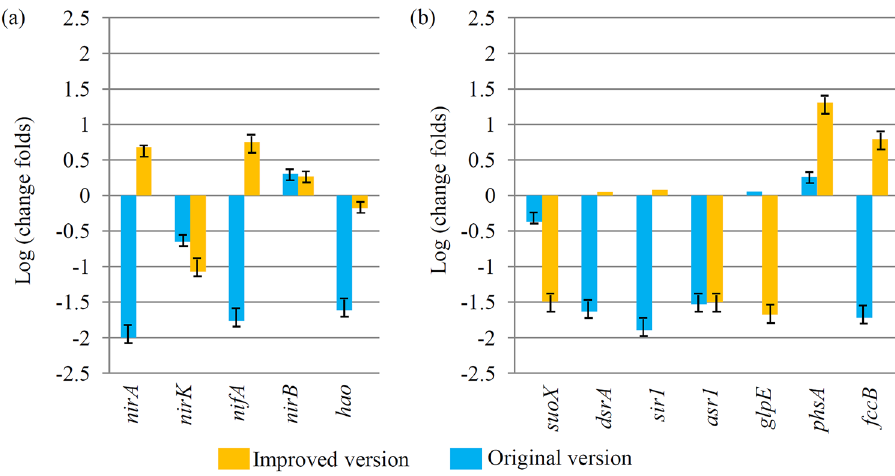
Figure 6. Comparison of the functional genes between original and improved biofilters. ( a ) The average expression levels of nitrogen metabolic pathway-related genes in both of the original and improved biofilters. ( b ) The average expression levels of sulfur metabolic pathway-related genes in both of the original and improved